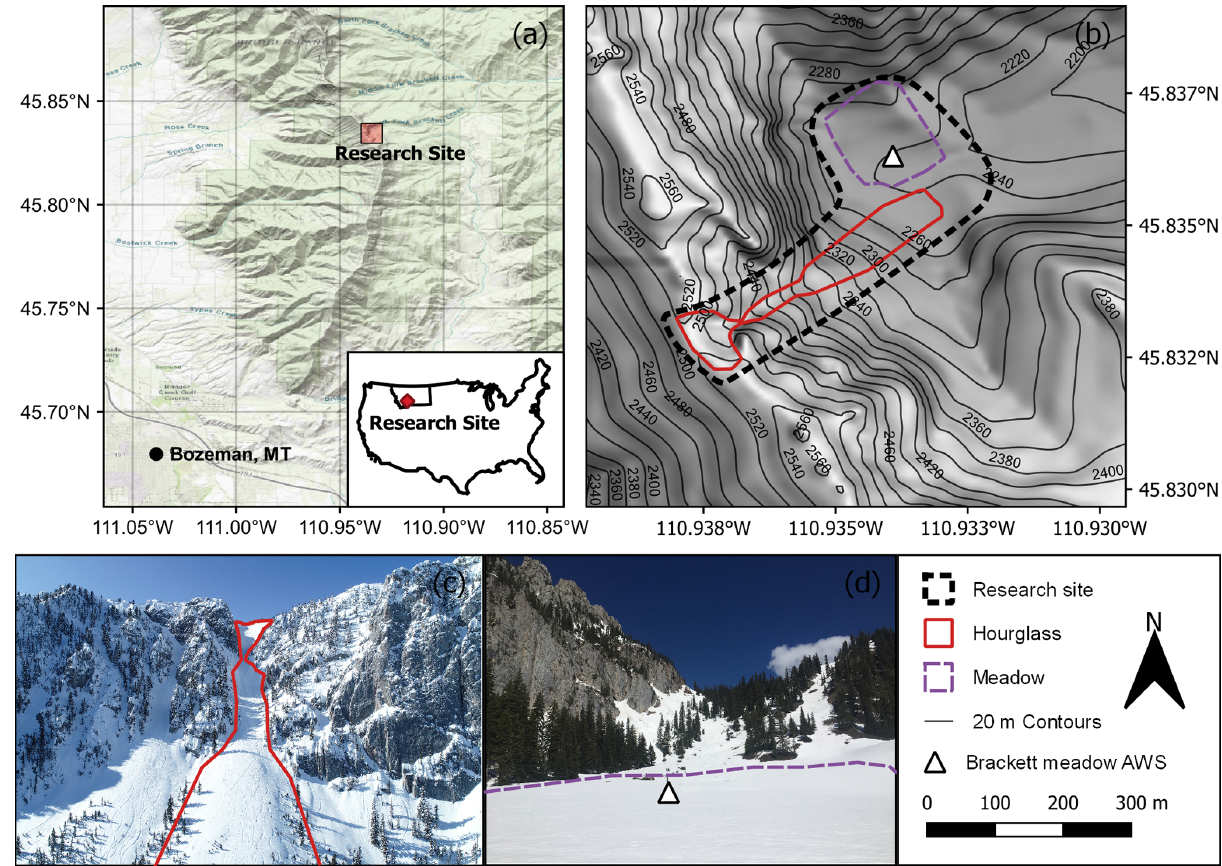
Figure 1. Study location in the Bridger Range of Montana, USA (a) , and overview topographic map of the study area (b) . The general research site (dotted polygon), the Hourglass couloir (solid red), the meadow (dashed purple), and the Brackett meadow AWS (white triangle) are shown. Photographs of the Hourglass couloir (c) and meadow (d) with the couloir and meadow polygons outlined. Data map source: U.S. Geological Survey